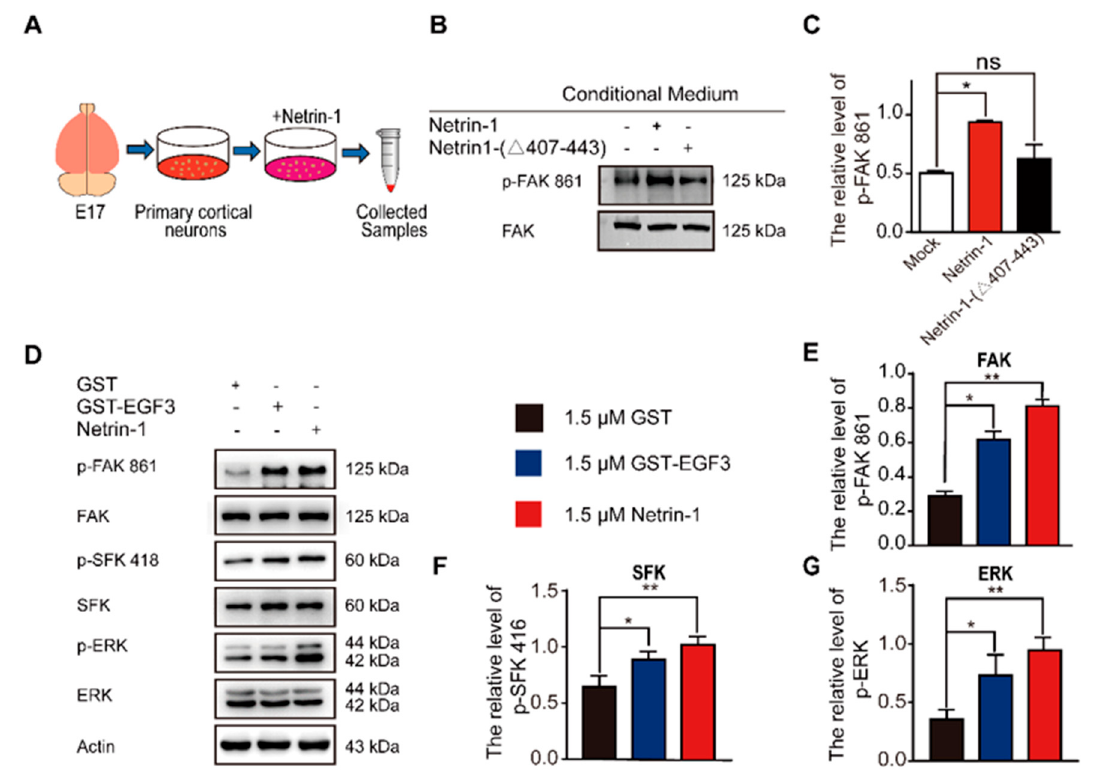
Figure 2. EGF3 domain activates downstream pathways of Netrin-1. ( A ) Experimental procedure. ( B ) Cortical neurons (E17 and DIV3) were stimulated with Netrin-1, Netrin-1-( ∆ 407–443) or control medium for 20 min. Cell lysates were incubated with an anti-p-FAK-861 antibody to confirm Netrin-1 activity. ( C ) Quantitative analysis of the western blot results shown in ( B ). n = 3. ( D ) Cortical neurons (DIV3) were treated with 1.5 µ M GST (+), 1.5 µ M GST-EGF3 fusion protein (+) or 1.5 µ M Netrin-1 (+) medium for 20 min. Cell lysates were incubated with anti-p-FAK-861, anti-p-SFK-418 and anti-p-ERK-202/204. ( E – G ) Quantitative analysis of the western blot results shown in ( D ). n = 3. Data are presented as the means ± SEM. One-way ANOVA was used for all statistical analyses shown in this figure (* p < 0.05, ** p < 0.01; ns, not significant). Details of data analysis are seen in Supplementary Table